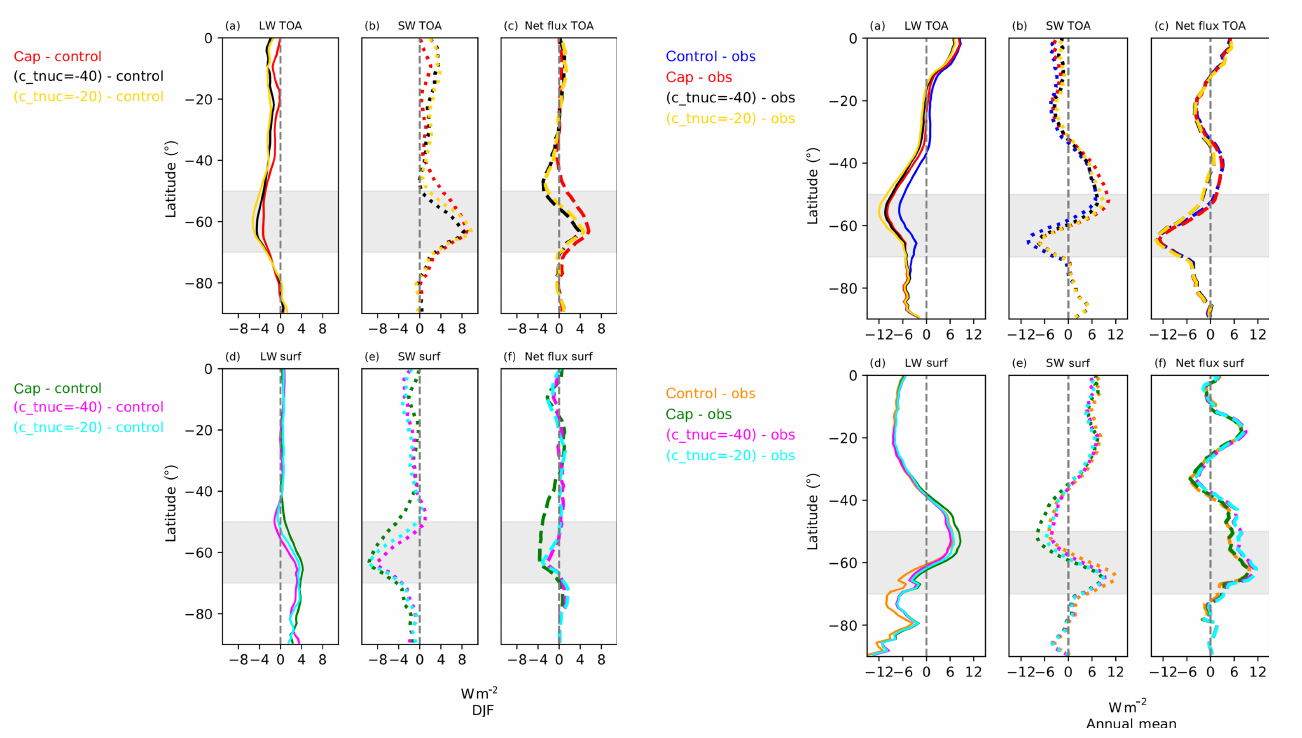
Figure 4. Distribution of zonally averaged annual-mean radiative flux anomalies in various model experiments with respect to obser- vations for the SH. Panels (a–c) represent the TOA (upward) radia- tive flux anomalies and (d–f) represent the surface (downward) flux anomalies. The solid lines in panel (a) indicate LW at TOA, dotted lines in panel (b) indicate SW at TOA, and dashed lines in panel (c) indicate net flux at TOA (i.e. LW plus SW at TOA). Colour codes for TOA fluxes are as follows: blue indicates control minus obs; red in- dicates cap minus obs; black indicates ( c_tnuc=-40 ) minus obs; and yellow indicates ( c_tnuc=-20 ) minus obs. Similarly, the solid lines in panel (d) indicate LW at surface, dotted lines in panel (e) indicate SW at surface, and dashed lines in panel (f) indicate net radiative heat flux at surface (i.e. incoming LW plus SW at surface minus (sensible heat plus latent heat). Colour codes for surface fluxes are as follows: orange indicates control minus obs; green indicates cap minus obs; magenta indicates ( c_tnuc=-40 ) minus obs; and cyan in- dicates ( c_tnuc=-20 ) minus obs. Annual-mean values for model are calculated from daily-mean output over 22 years. The net surface flux observational data are a combination of both TOA fluxes from satellite and ERA-Interim reanalysis energy divergences (details in Sect. 2.2). The SO region identified in this study is highlighted in